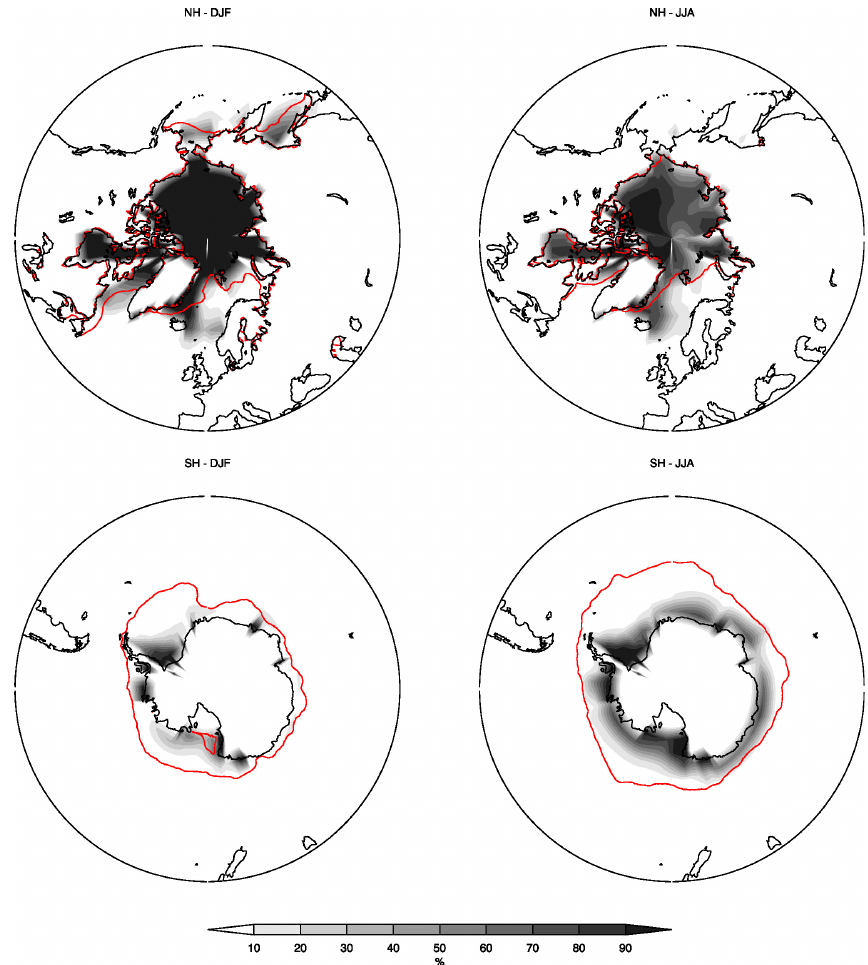
Fig. 11. Fractional sea-ice extent. HadISST v1.1 15% observed contour plotted in